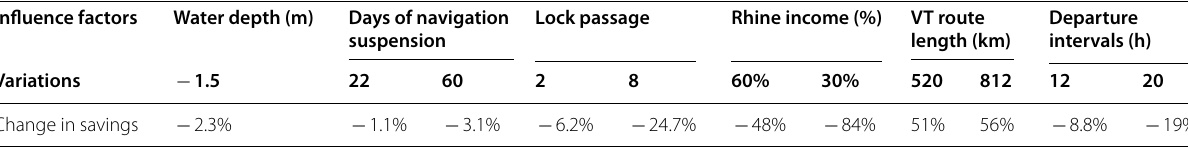
Table 8 Average change in cost savings due to the variation of influence parameters Influence